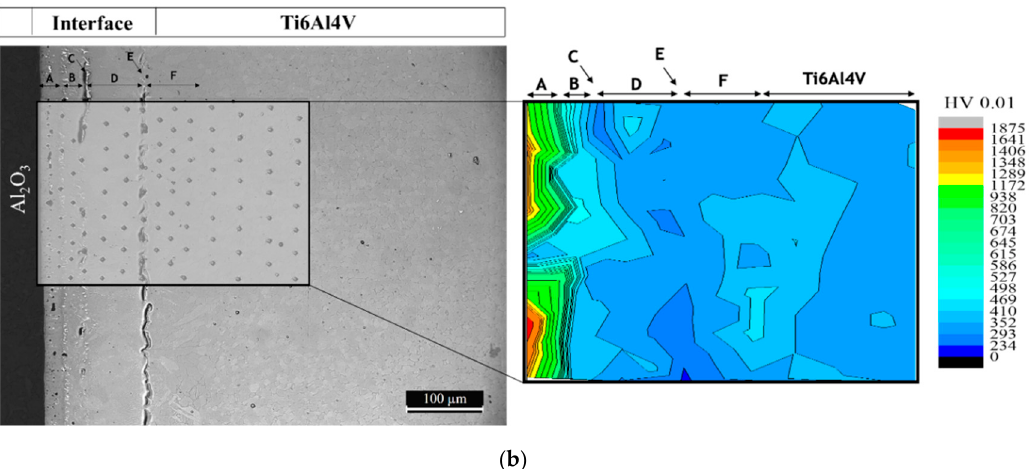
Figure 7. Optical microscopy (OM) image and hardness distribution maps of the ( a ) Al 2 O 3 / γ -TiAl alloy, and ( b ) Al 2 O 3 /Ti6Al4V brazed joints.